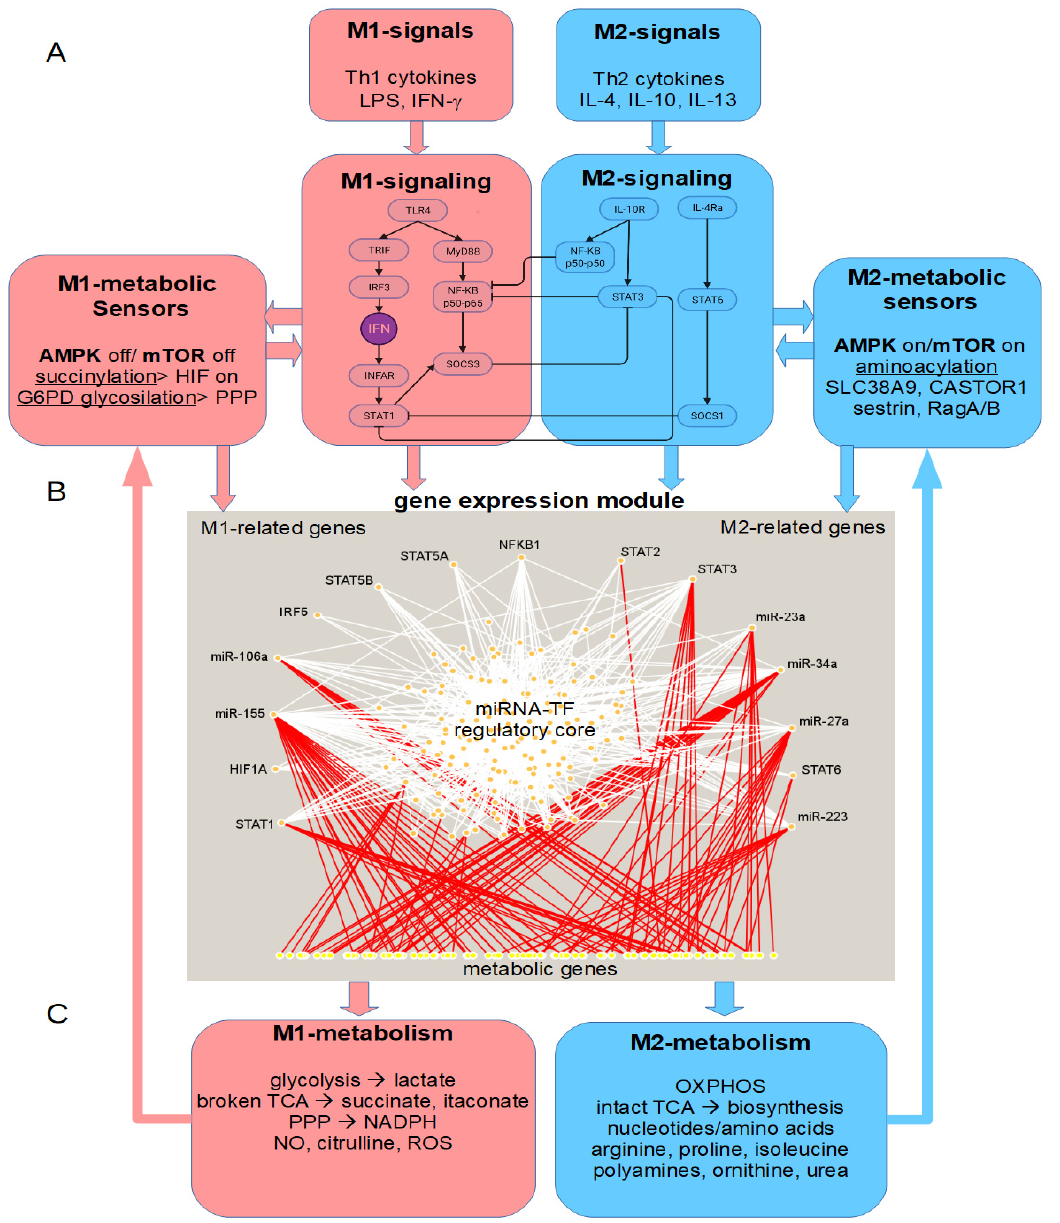
Figure 3. Integrated perspective of the bistability and the switchlike circuits in macrophage M1 and M2 activation: ( A ) M1 and M2 signals activate their respective signaling modules, including mutually inhibitory interactions with potential bistability and the influence of the metabolic master regulators mTOR and AMPK. ( B ) The signaling modules modulate the gene expression of several miRNAs and transcription factors that assemble a complex regulatory core network with the potential emerging property of bistability, including many counter regulators in M1/M2 gene expression. These gene expression modules in turn alter the expression of metabolic genes in a switchlike fashion. ( C ) The differences in M1/M2 macrophage metabolism due to gene expression include contrasting pathways regarding energy production, nitrogen metabolism, TCA cycle, NO, ROS and biosynthesis. The products of this metabolism shape the metabolic microenvironment, which is in turn sensed by the same metabolic pathways or by specialized sensors that report to the master regulators of cell metabolism: mTOR and AMPK (see A ). These master regulators influence signaling and gene expression to maintain the corresponding phenotypes, conferring stability to the alternative steady states of macrophage activation.